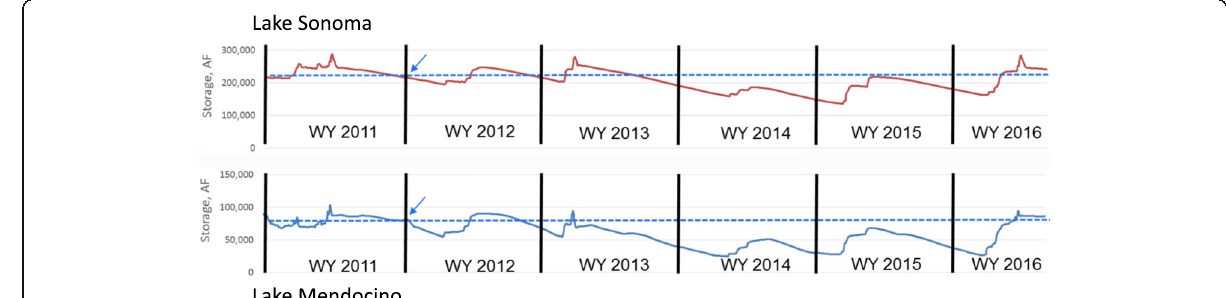
Fig. 6 Reservoir storage for water years 2011 – 2016 for Lake Sonoma and Lake Mendocino, with the dotted line indicating the storage at the end of the very wet water year 2011 for comparison